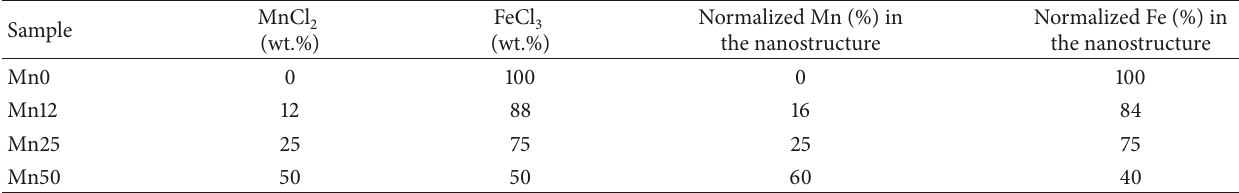
Table 1: Weight percent (wt.%) and effective concentration of manganese and Fe in the studied samples (the values were normalized considering that Fe (%) + Mn (%) =